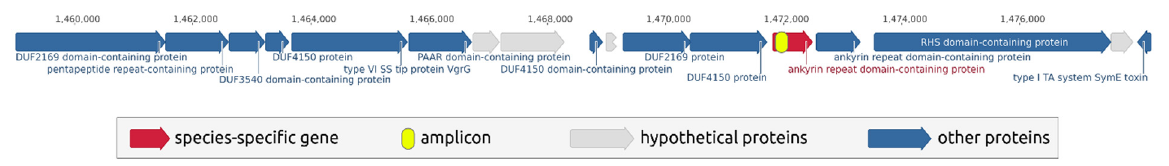
Figure 2. Region in the P. parmentieri RNS 08-42-1AT genome containing a species-specific sequence. The scheme was visualised using Geneious Prime 2021.2.2 (https://www.geneious.com, accessed on 20 January 2021).